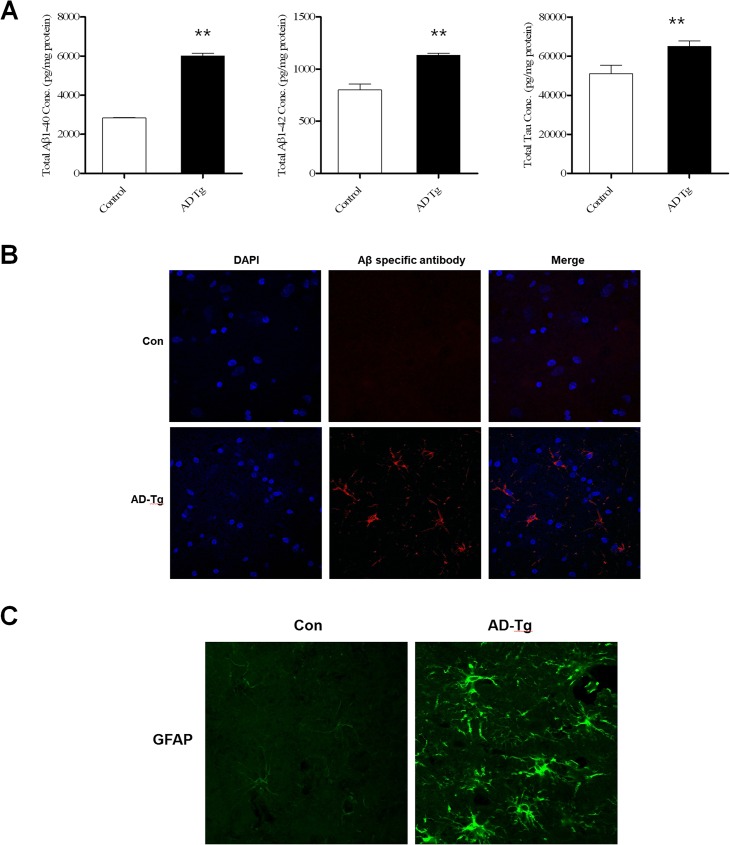
Bio-marker analysis of Tg pigs.(A) Quantification of Aβ1–40, Aβ1–42, and total Tau in the cortex of control (blank box) and Tg brains (black bar) using ELISA. All three gene expression was elevated in the TG brain. (B) Expression of APP in the cortex region of JNUPIGs confirmed by immunohistochemistry stained with anti-Aβ specific antibody. (C) Astrocyte activation, monitored by GFAP level, in control and Tg brain. GFAP level was highly elevated in TG brain. Images, taken at 400× magnification, are representative of at least four sections per animal. Data were analyzed by independent samples t-test in SPSS (*: p < 0.05, **: p < 0.01). The experiment was repeated three independent times.